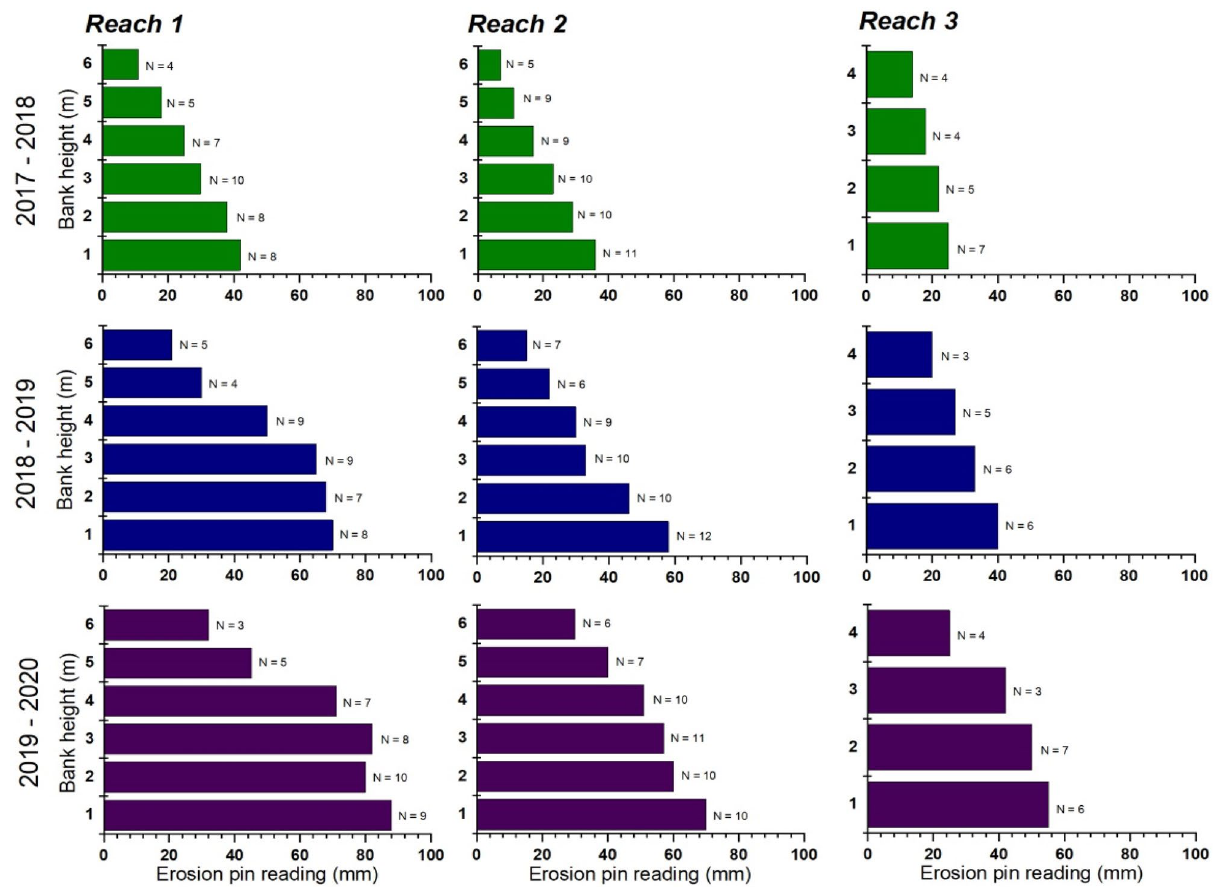
Figure 4. Mean erosion pin readings measured from the exposed bank faces within the three study reaches from June 2017 to December